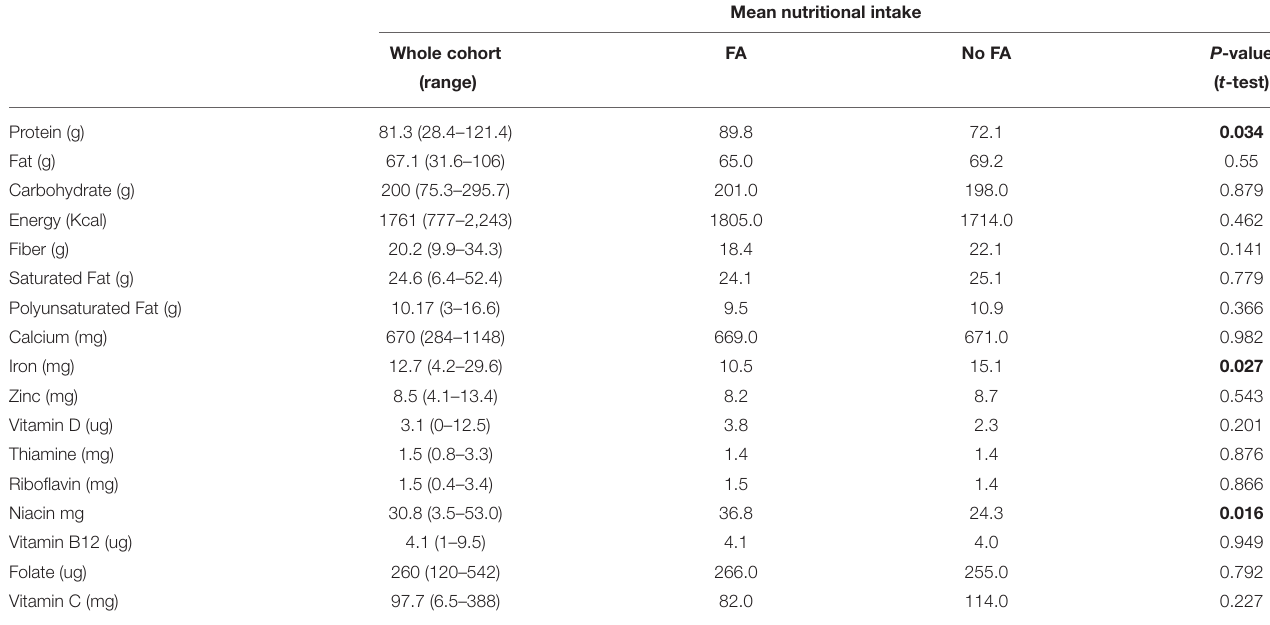
TABLE 3 | Results of the dietary assessment, showing the nutrient intakes for the whole cohort, and also for the group with food allergy, compared to those with no food allergy. Mean nutritional intake Whole cohort FA No FA P